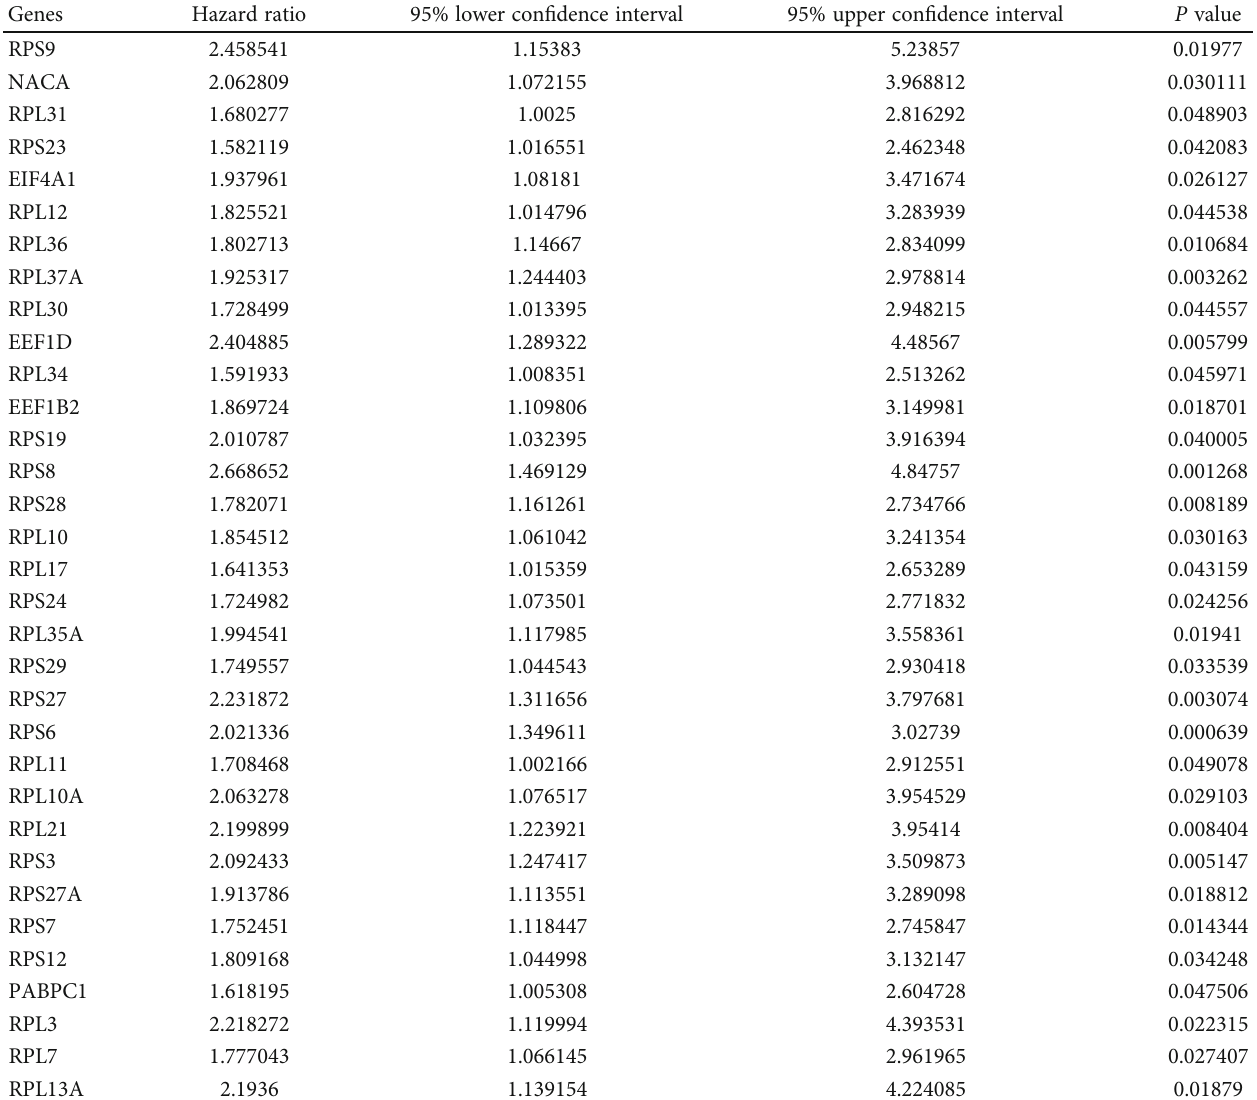
Table 2: Prognostic EMT-derived genes in the TARGET